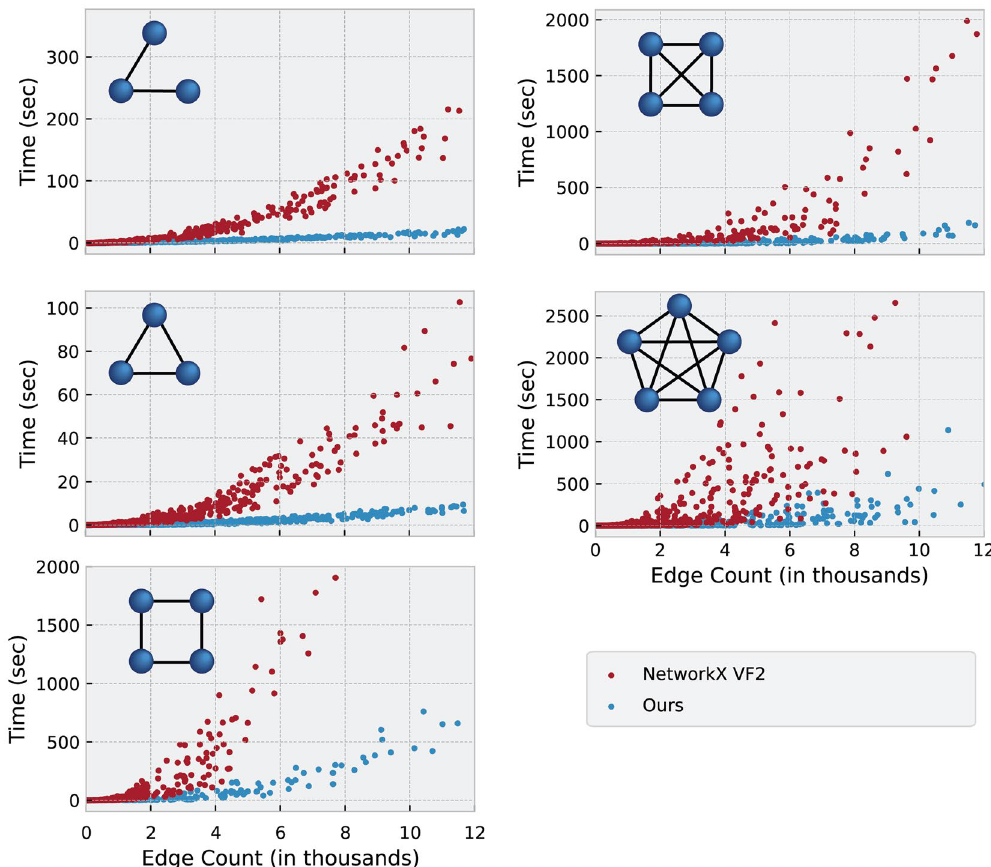
Figure 5. Comparison of wall-clock runtime when counting undirected motifs. All runtimes are measured during motif searches in Erdős–Rényi graphs with node-count sampled uniformly on the interval of 100–300 nodes, and with densities randomly sampled between 0 and 0.3. See Benchmarks for more details. Here, we compare performance on a variety of motifs, such as the three-node path graph, the four-node cycle graph, and complete cliques of various